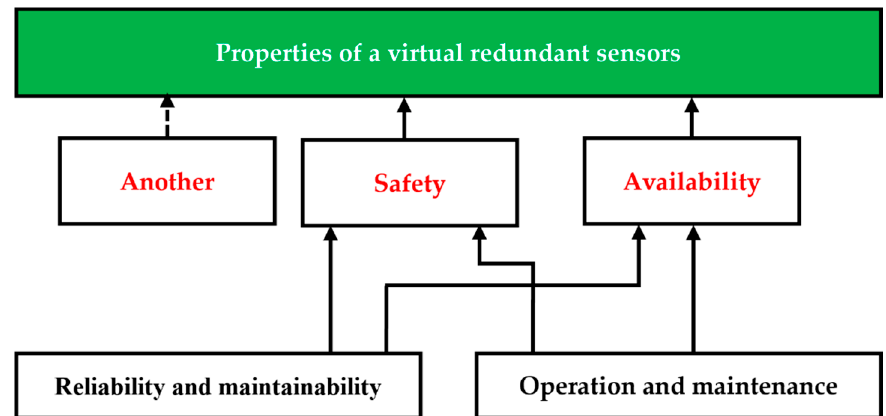
Figure 4. The relationship between the RAMS parameters and virtual redundant sensors.